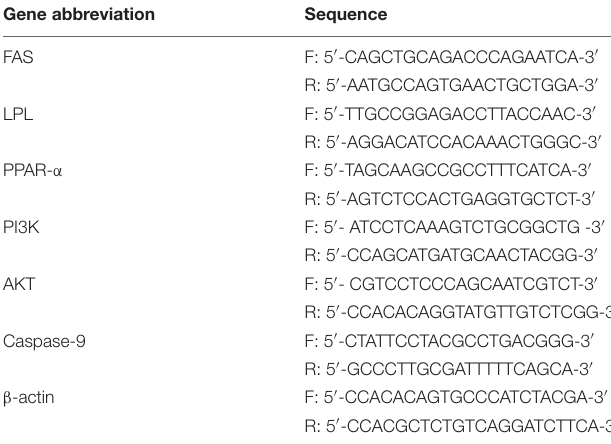
TABLE 1 | The primer sequence of the gene in this experiment. Gene